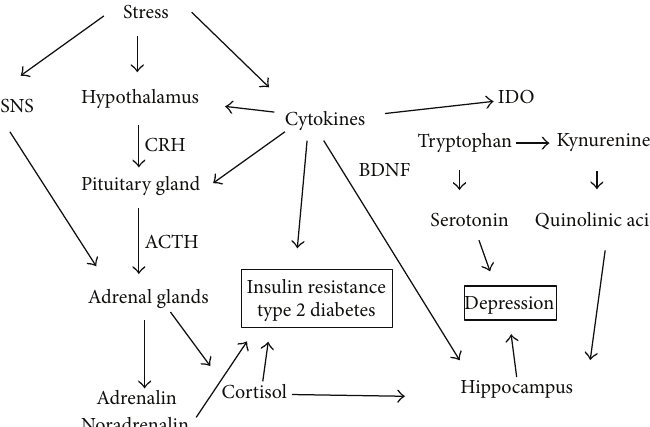
Figure 2: The stress response and possible pathophysiological mechanisms contributing to type 2 diabetes and depression.